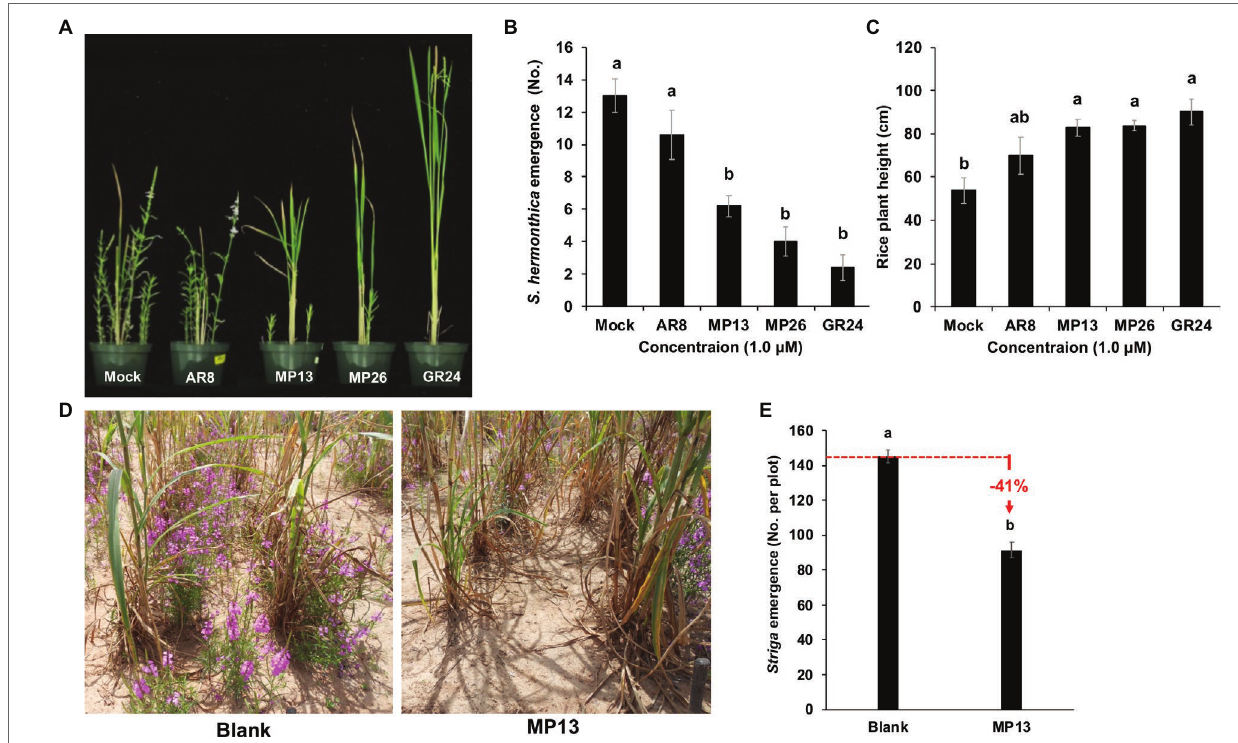
FIGURE 8 | (A) Striga hermonthica emergence in pots under greenhouse conditions. (B) Number of Striga emergence per pot in response to SL analogs’ application. (C) Rice plant height in response to SL analogs’ application. About 4,000 Striga hermonthica seeds were thoroughly mixed in 2 L of sand and soil mixture. After 10 days of preconditioning, each pot was sprayed with 20 ml formulated SL analogs (conc. 1.0 μ M) for five times up to 10 days. After 1 week of application, three rice seedlings were planted in the middle of each pot. Number of emerged Striga plants in each pot were counted after 8 weeks of sowing and plant height was measured at the time of final counting. We conducted this experiment two times and the same tendency was observed in both studies. (D,E) Striga emergence in response to suicidal effect of formulated MP13 application under naturally infested farmer field conditions. After onset of rainfall, formulated MP13 and normal water (control) were applied twice in each plot (25 ml m −2 ) following rains ( ≥ 10 mm) to get final concentration of 0.5 μ M. The experiment was conducted in a randomized complete block design ( n = 4). Bars represent number of Striga emergence per plot and compared by one-way ANOVA. Means not sharing a letter in common differ significantly at p 0.05